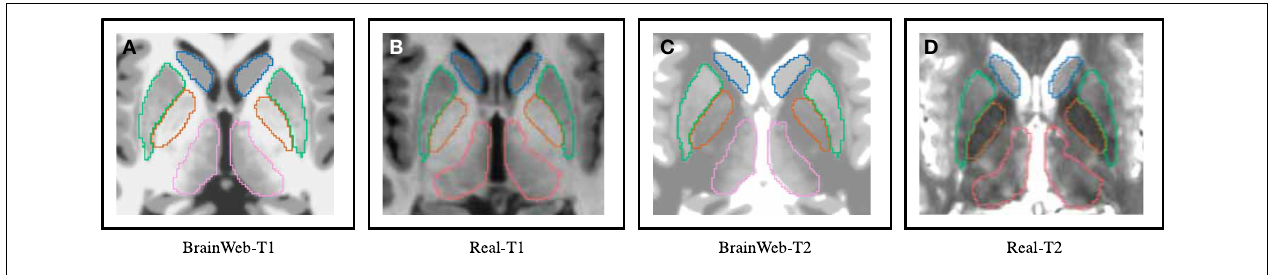
FIGURE 7 | Distinguishable intensity profile differences between BrainWeb and real MR data. Difference is more obvious for the globus pallidus (orange) region, where BrainWeb data appears medium gray both in